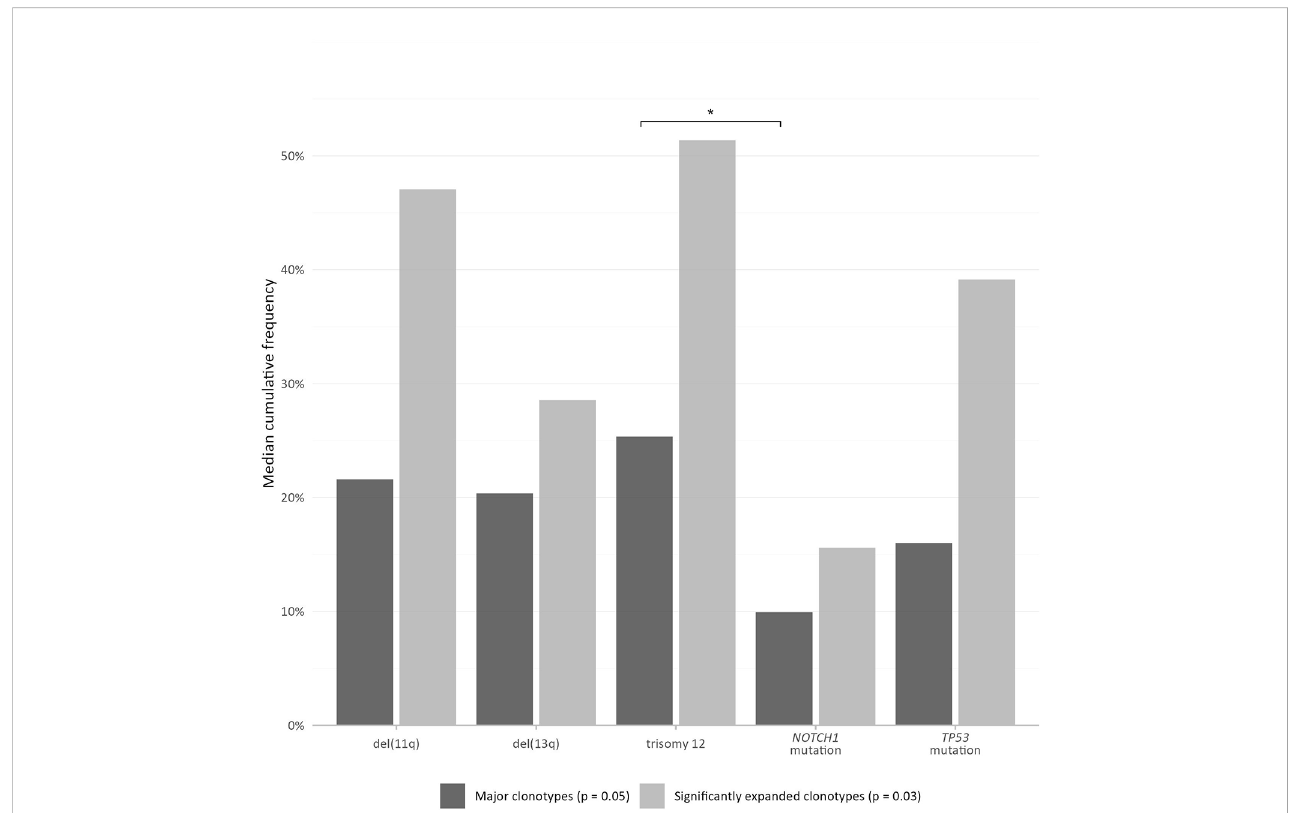
FIGURE 2 More pronounced TR repertoire skewing in cases bearing copy number aberrations, particularly trisomy 12, versus gene mutations. The bars represent the median cumulative frequency of the major clonotypes in each group (MCF-10) in dark grey color, and the median cumulative frequency of the signi fi cantly expanded clonotypes in each group (ex-MCF), in light grey color. The asterisk (*) refers to statistical signi fi cance at the level of a =0.03 following post-hoc comparisons using Benjamini-Hochberg